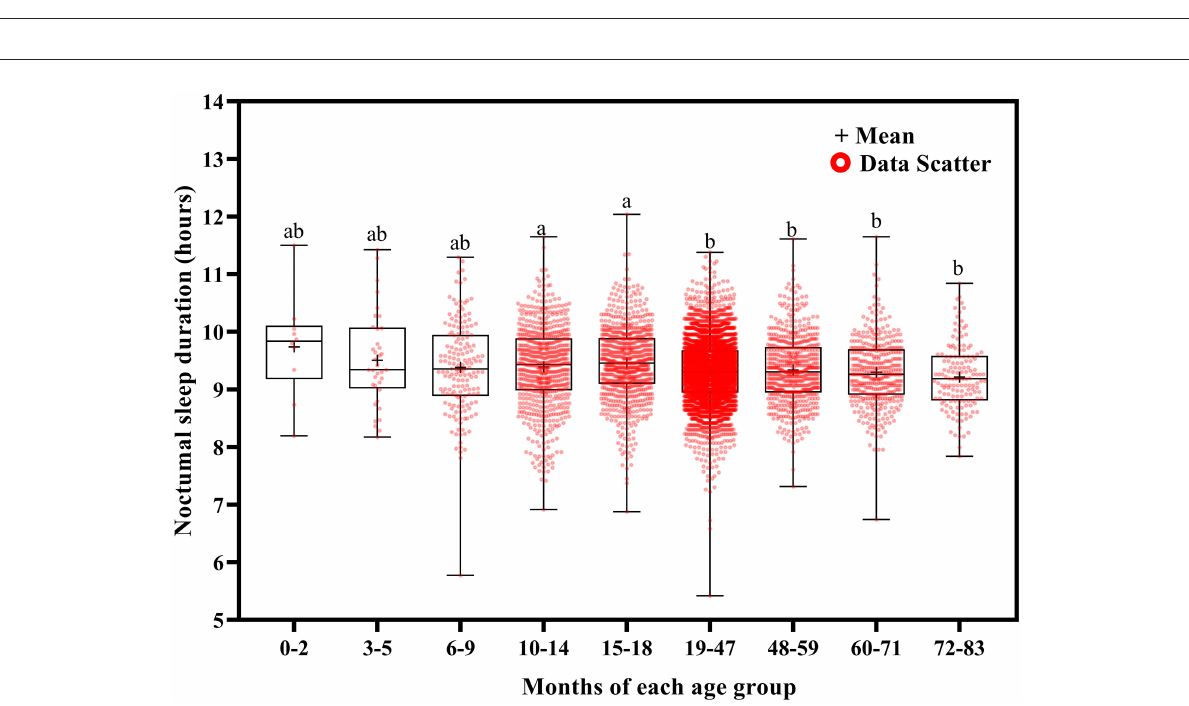
FIGURE7 Results of the one-way ANOVA for noctumal sleep duration stratified by age.